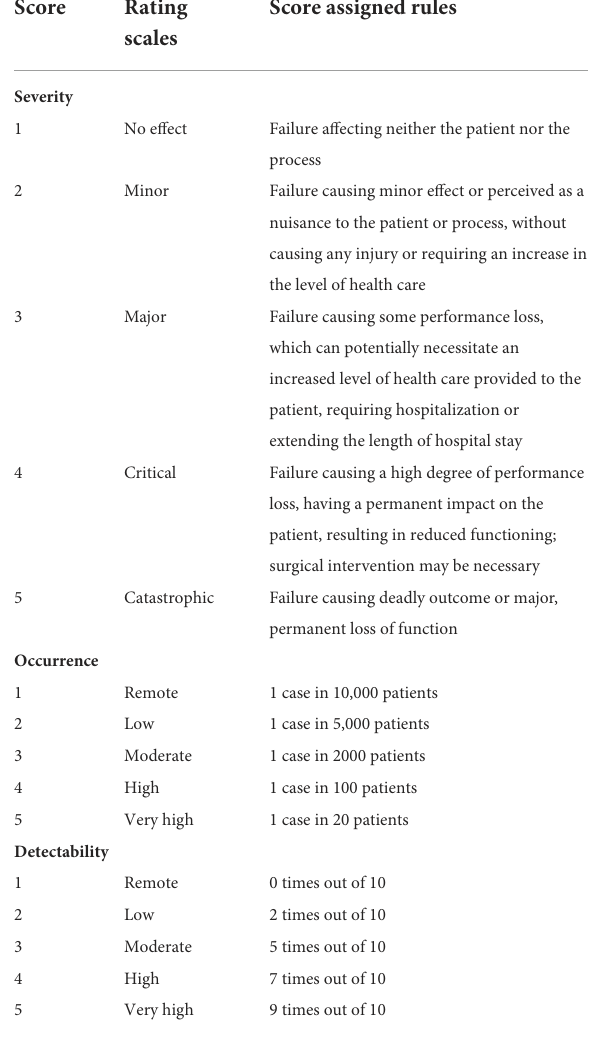
TABLE 1 Ranking scale for failure modes’ severity, occurrence and detectability